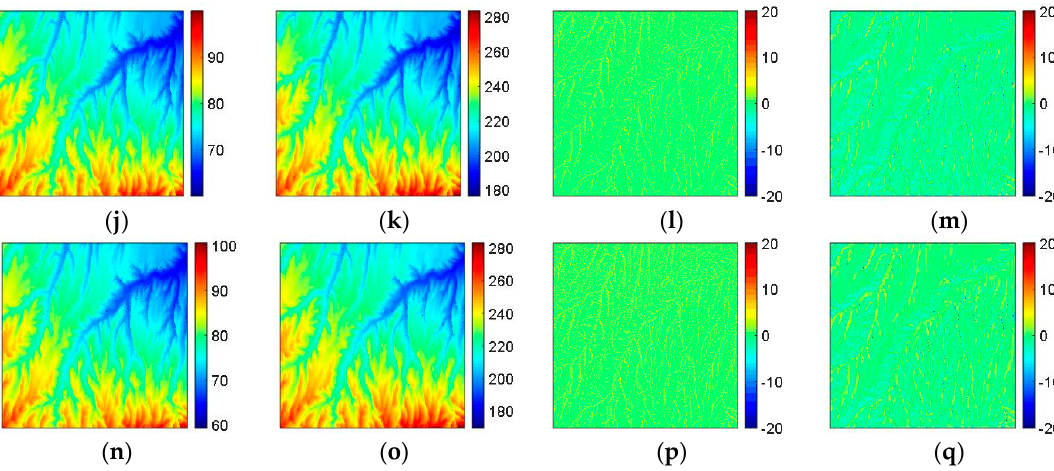
Figure 6. ( a ) Google Earth image of the study area. ( b , c ) TanDEM-X interferograms with different baseline lengths (( b ) short and ( c ) long baseline length). ( d , e ) The reference unwrapped phases of ( b , c ). ( f , g ) PU results of ( b , c ) obtained by PUMA (clique potential exponent is 0.5). ( h , i ) Errors between ( d , e ) and PU results ( f , g ). ( j , k ) PU results of ( b , c ) obtained by DB TSPA. ( l , m ) Errors between ( d , e ) and PU results ( j , k ). ( n , o ) PU results of ( b , c ) obtained by DB TSPA-PUMA. ( p , q ) Errors between ( d , e ) and PU results ( n,o ). Table 4. Major interferometric parameters of real DB dataset of TanDEM-X.